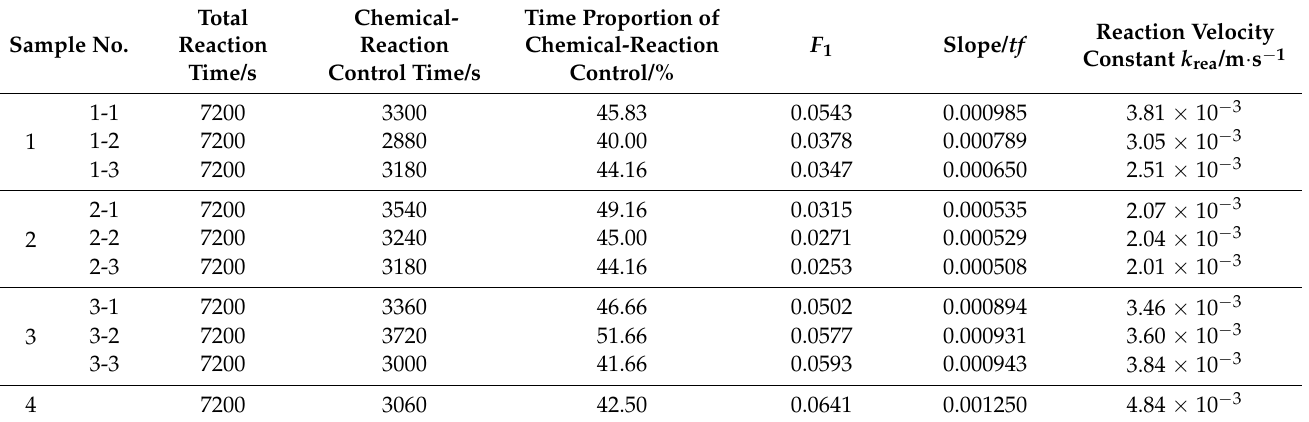
Table 5. Chemical-reaction kinetics parameters during sinter-reduction process at the early stage.